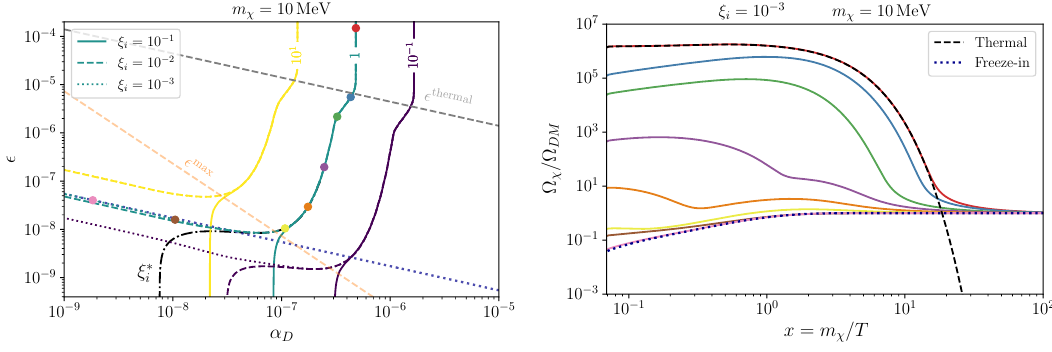
Figure 2 . Left panel : contours of Ω χ / Ω DM in the α D – (cid:15) plane for different initial temperature ratios. The gray dashed line corresponds to the maximum value of (cid:15) for a given α hidden sector reaches thermal equilibrium with the SM (3.4). The dark blue dotted line indicates the traditional freeze-in production (2.4), and the orange dashed line shows the upper bound (cid:15) max as a function of α (2.9) for which elastic scattering is negligible and a frozen-in DM phase space D distribution evolves only through redshifting. Right panel : evolution of the ratio Ω for each colored point shown in the left panel, where the final yield of χ matches the observed DM relic